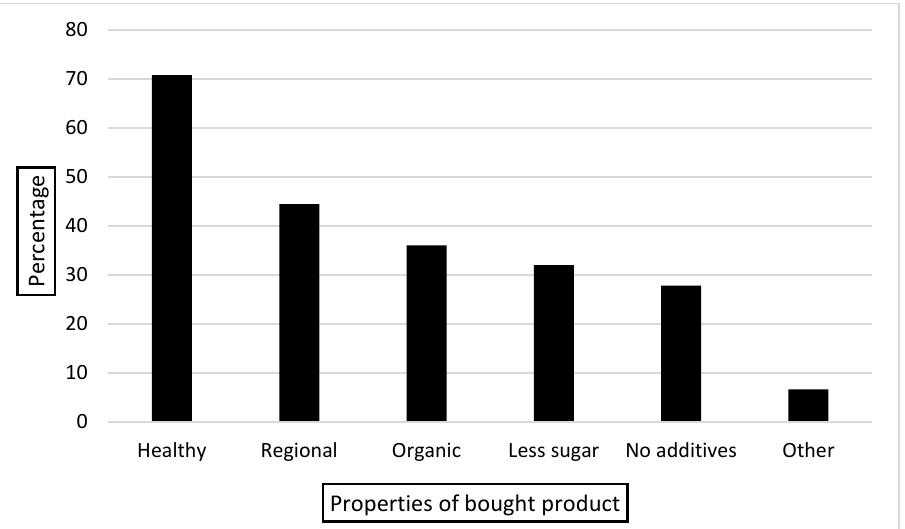
Figure 3. Important properties of bought products. Other: enjoyable (child-oriented), unprocessed (fresh, from own garden/farm, directly from producer, self-made), balanced (diverse, everything in moderation), free or low on certain food or food component (lactose, sugar, peanut, glutamate, palm oil, caffeine, pork, salt, protein, histamine), seasonal, vegetarian/vegan, Demeter, affordable, origin, nutrient content, whole wheat, quality, hygiene, no Nestlé, calorie and fat content.